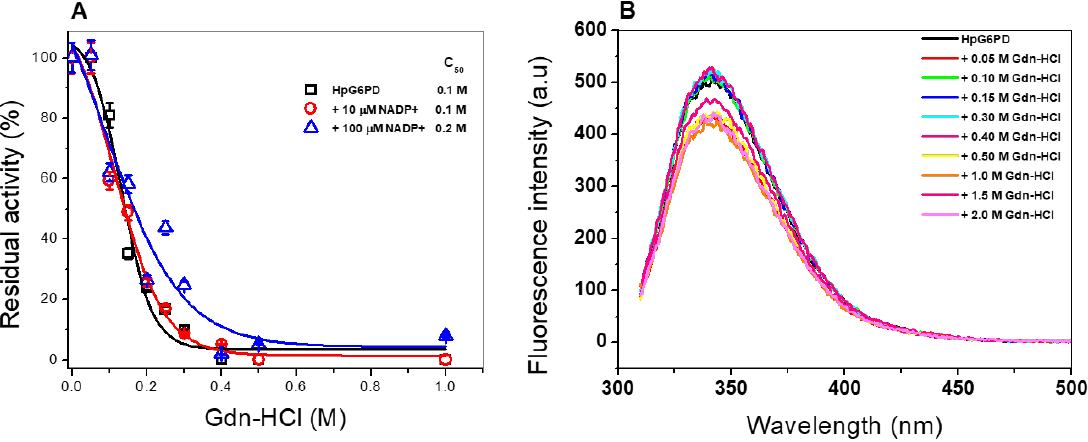
Figure 8. Stability and structural analysis of HpG6PD via intrinsic fluorescence. ( A ) Stability analysis in the presence or absence of Gdn-HCl. ( B ) Intrinsic fluorescence intensity of HpG6PD at different Gdn-HCl concentrations. Assays were performed in triplicate, with standard errors of less than